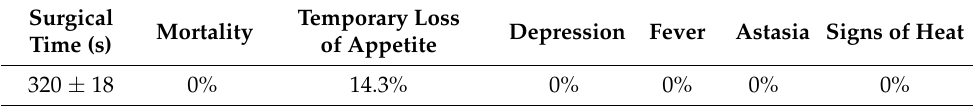
Table 1. Postoperative clinical observation of spayed heifer.